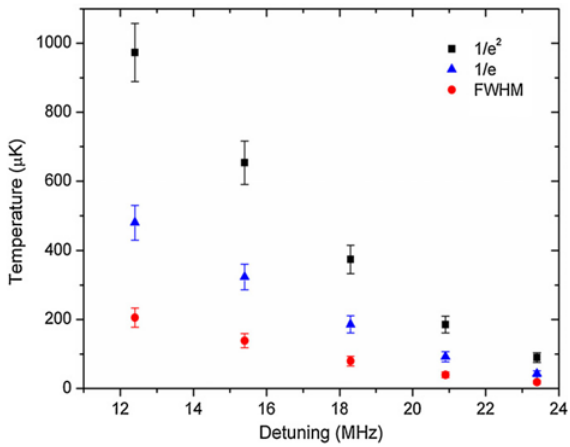
Figure 7. Atom cloud temperature as a function of detuning of the cooling laser beams for three standard definitions of cloud radius. The measurements were made using the forced oscillation technique and indicate that sub-Doppler temperatures <144 μK can be achieved in the presence of an ONF. Reprinted with permission from [3]. Copyright 2012 Institute of